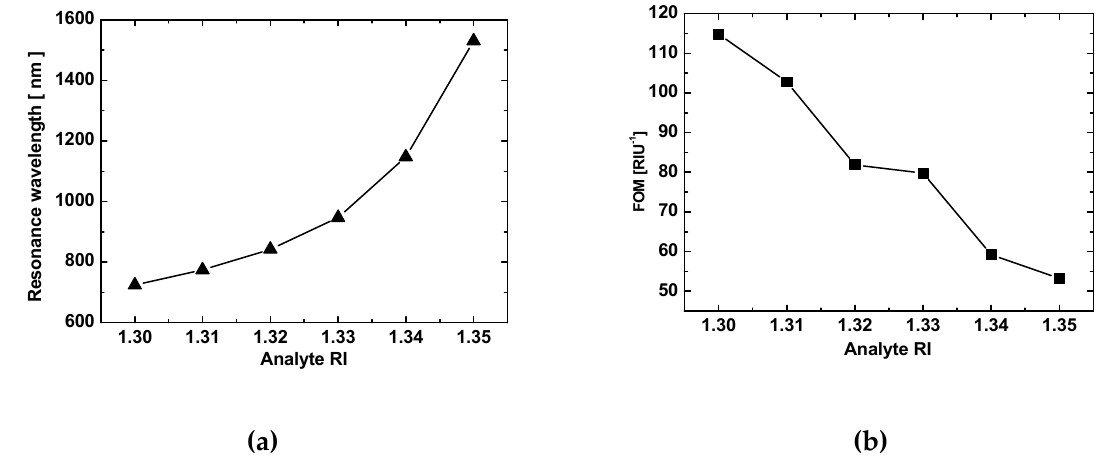
Figure 8. Resonance wavelength ( a ) and FOM ( b ) as a function of analyte RI for the SPR sensing structure .